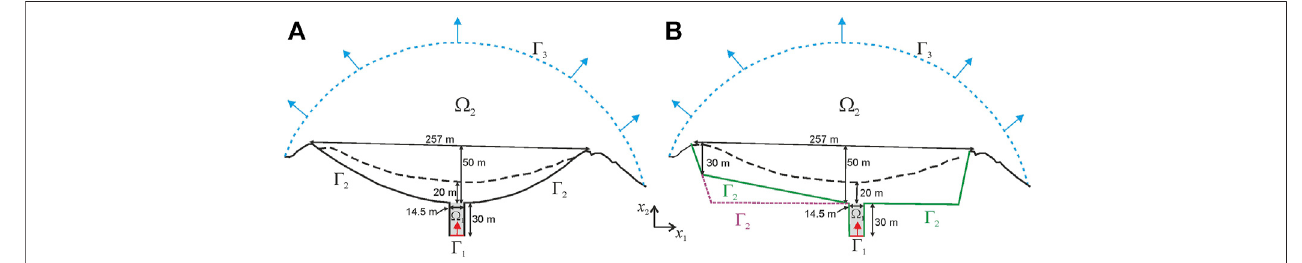
FIGURE3|(A) Thesketchofthemodeldomain Ω (cid:1) Ω 1 ∪ Ω 2 inexps.1 – 4and7.Theboldblackline ( Γ 2 ) presentsthebaseofthecraterandtheverticalboundaries of the model conduit; the dashed black line is the observed rim of the crater; the red line ( Γ 1 ) is the part of the model boundary, where a new magma enters into the conduit(sub-domain Ω 1 ) fi lledbyanoldermagma(gray-shaded),andtheredarrowindicatesthedirectionofthenewmagmaascentwithintheconduit.Theblueline ( Γ 3 ) markstheupper boundary ofthedomain, through which theair escapes from themodel; blue arrows show thedirection ofthe escape. The geometry